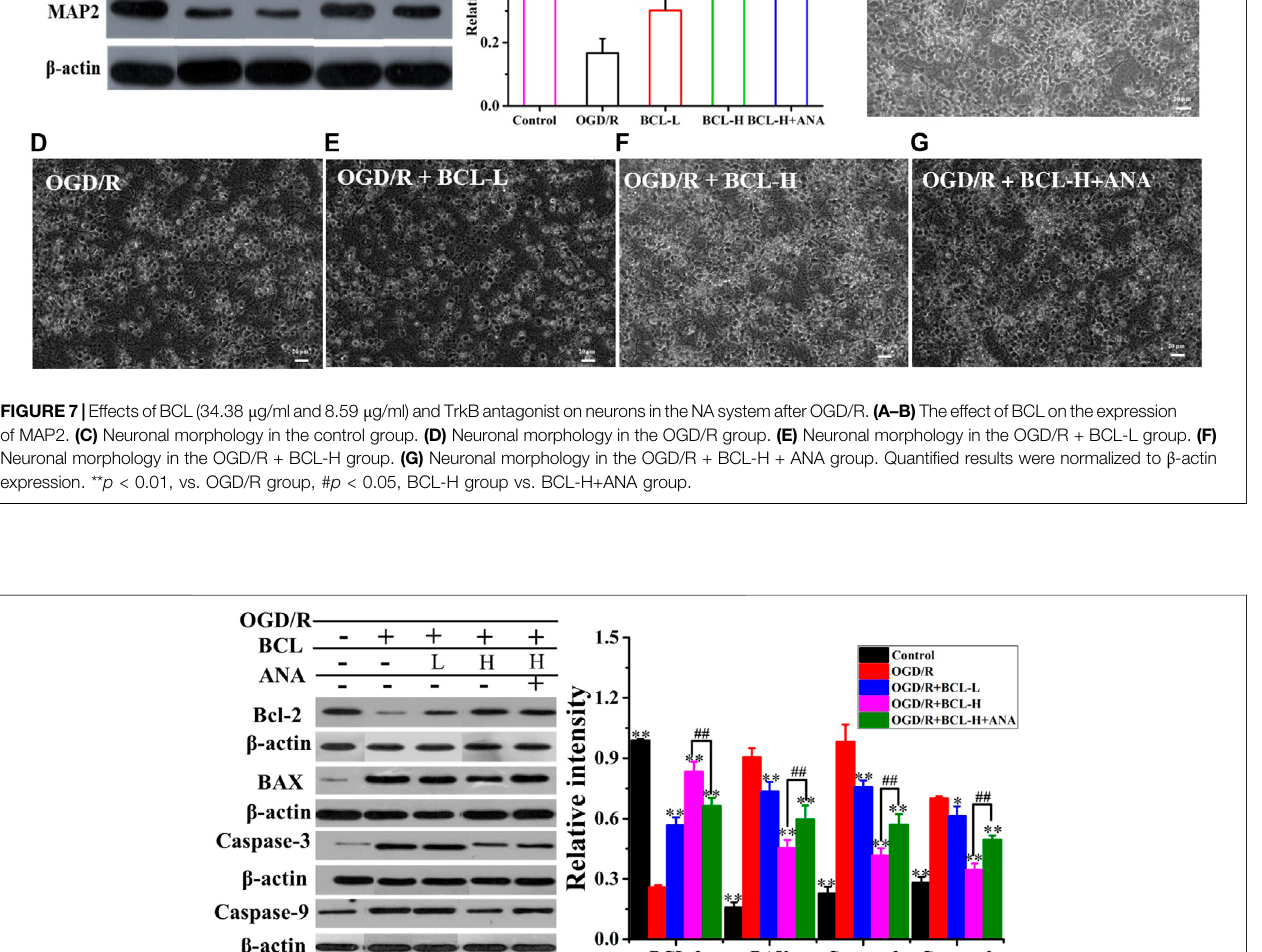
FIGURE 8 | Effect of BCL (34.38 μ g/ml and 8.59 μ g/ml) on apoptosis proteins after OGD/R. Quanti fi ed results were normalized to β -actin expression. ** p < 0.01, * p < 0.05, vs. model group, ## p < 0.01, OGD/R + BCL-H group vs. OGD/R + BCL-H + ANA group.